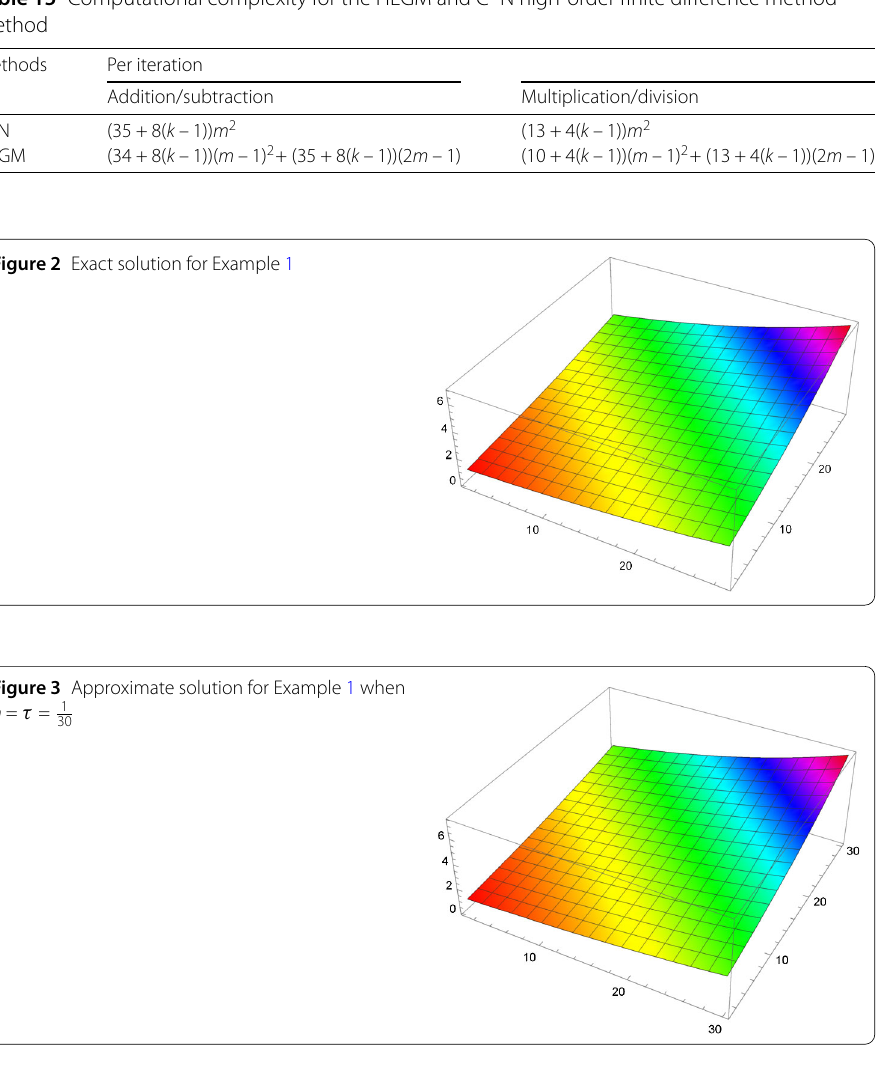
Table 14 C 1 -order of convergence for Example 3, when h = 1